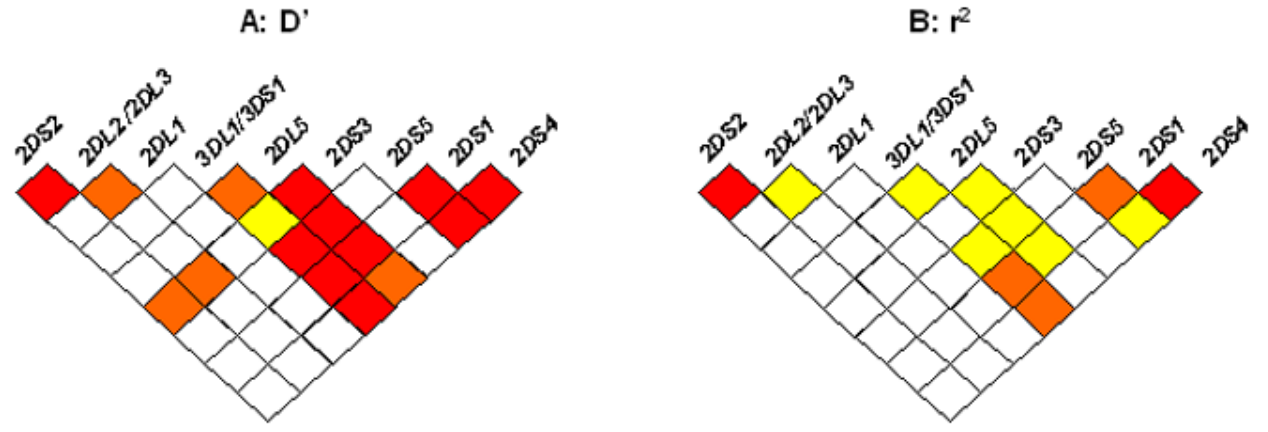
Figure 4. Pairwise linkage disequilibrium between KIRgenes in the family sample. This analysis was based on the genotypes reconstructed after the first step, without using any information about LD pattern between KIR genes. Each square represents the magnitude of pairwise LD between KIR genes, as measured by D’ (panel A) or r 2 (panel B). Red squares represent a |D’| or r 2 value of 1.0, corresponding to complete and perfect LD, respectively. Orange, yellow, and white squares indicate |D’| or R 2 values of [0.75-1[, [0.5-0.75[, and , 0.5, respectively.